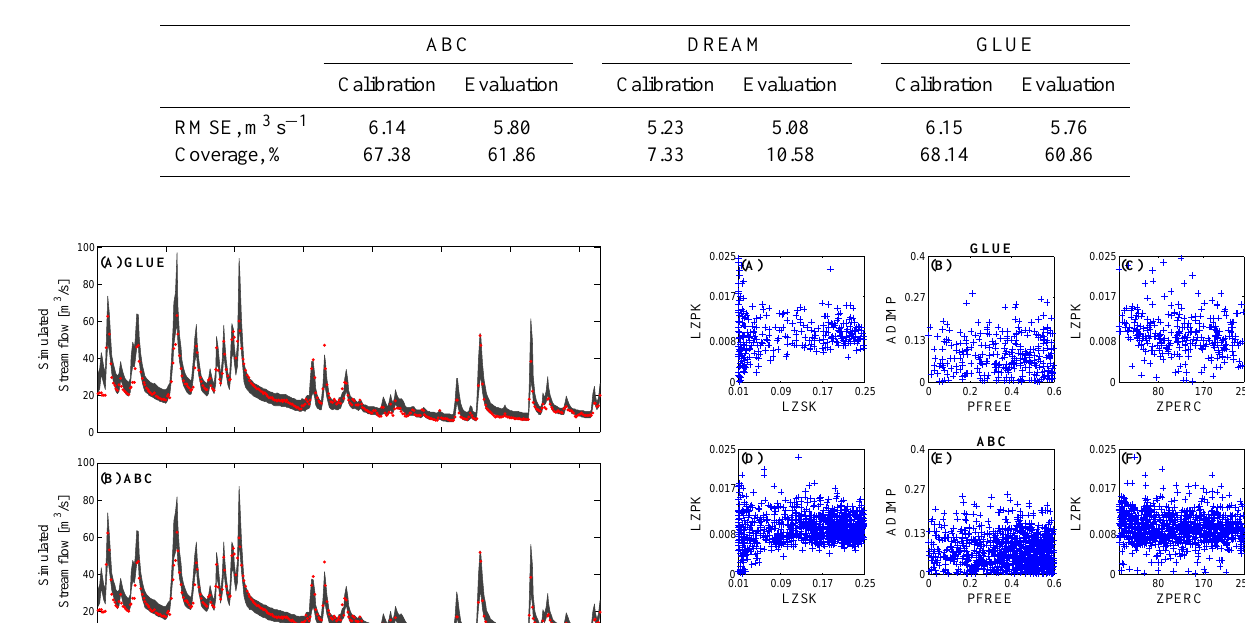
Table 5. Statistics of the GLUE, ABC and DREAM (formal likelihood function) derived posterior parameter distribution for the calibration and evaluation period of the French Broad river basin: root mean square error (RMSE) of the posterior mean hmodel simulation and coverage (%) of the associated 95% streamflow simulation uncertainty ranges.